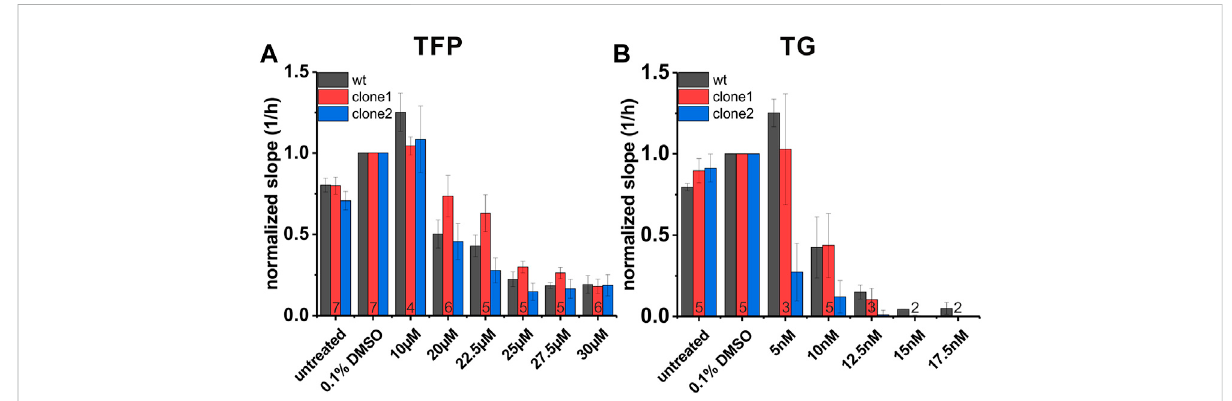
FIGURE 7 Proliferation behaviourofFaDuwtcellsand SEC62 -knockoutcelllinesunderTFP andTGtreatment.Fordata analysis theslopeofeachcellline wascalculatedwithinatimerangeof35 hupto60 haftercellseeding.Treatmentwasstarted5 haftercellseeding.Allmeasurementsweremadein technical quadruplicates, biological replicates were indicated at the bottom of the red column. Shown is the mean of the slope (1/h) normalized to solvent control(0.1%DMSO).Theerror barsindicatethestandarderrorofthemean (A) Proliferativebehaviourofthreedifferentcell linesunder TFP treatment (B) Proliferative behaviour of the same cell lines under TG treatment. FaDu wt cells (black bars), clone 1 (red bars) and clone 2 (blue bars). wt, wild